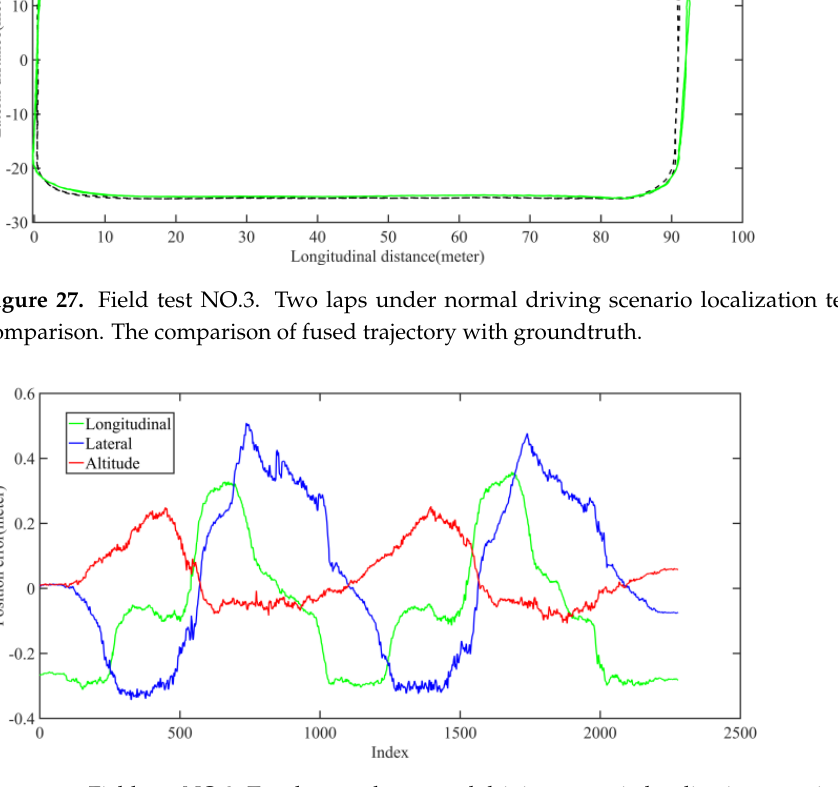
Figure 28. Field test NO.3. Two laps under normal driving scenario localization error in longitudinal, lateral, and altitude directions, respectively; the localization error is at the centimeter level.